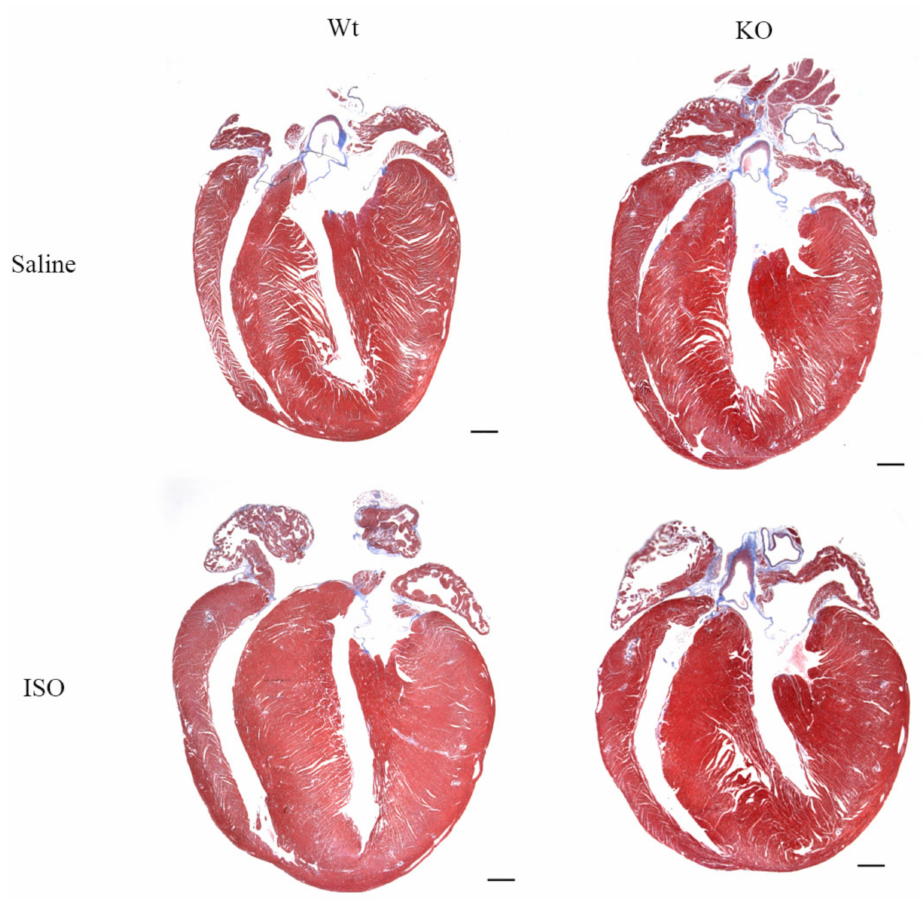
Figure 8. Histological analysis of ISO challenged Wt and SLMAP3-KO mouse hearts. Representative sectioning of Wt or KO hearts after one week of saline or ISO with Masson’s trichome stain to visualize the muscle and fibrosis. Scale bar = 500 µ m × 12.5